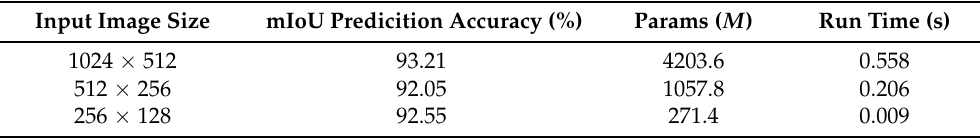
Table 6. mIoU prediction accuracy for different input sizes.